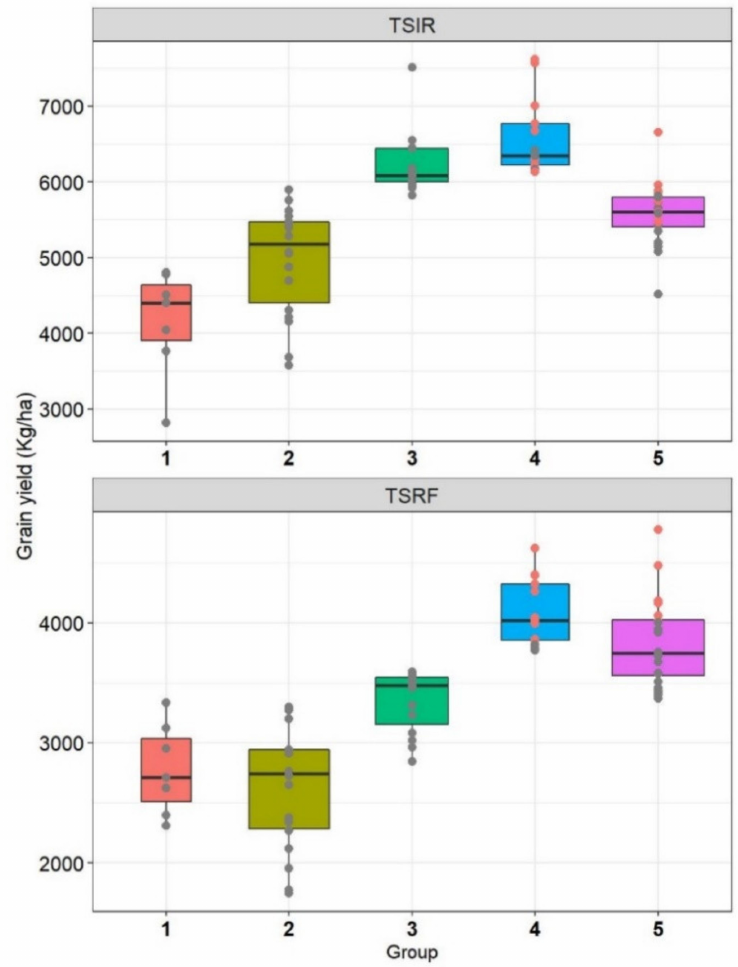
Figure 4. Boxplot of grain yield (kg/ha) at Tessaout under optimal conditions (TSIR) and rainfed conditions (TSRF) by cluster groups identified based on drought susceptibility/tolerance indices. A red color represents the lines selected by the mean score index